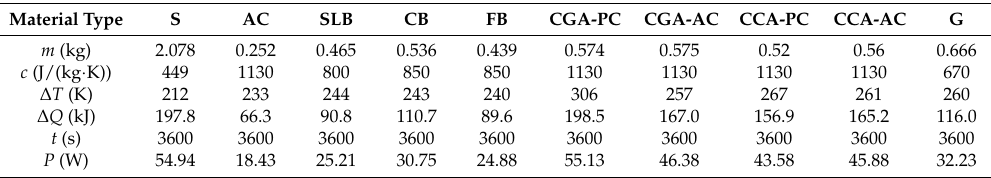
Table 8. The thermal power of materials tested—second stage of the experiment.